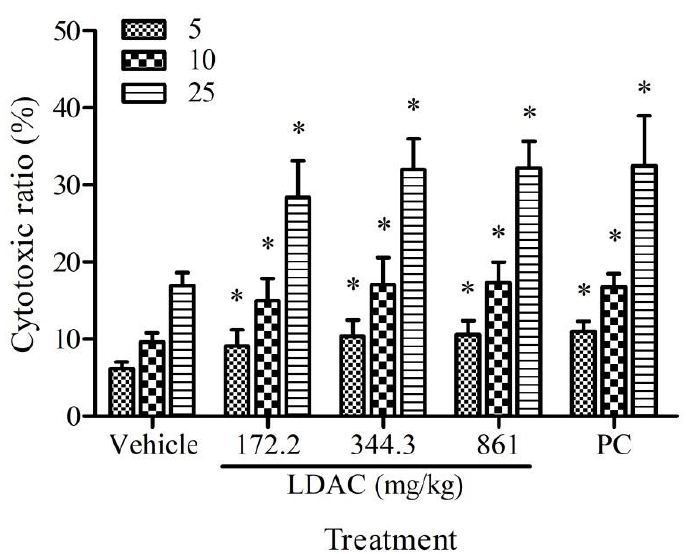
Figure 1. E ff ect of Leader Deluxe Taiwanofungus camphoratus capsule (LDAC) on cytotoxic activity of nature killer cells (NK). The mice were administered with LDAC (172.2, 344.4, 861 mg / kg) and positive control (PC, 633.5 mg / kg) for 6 weeks. The cytotoxic activity of natural killer cells was measured by incubation of e ff ector cells (NK cells) with target cells (YAC-1 cells) at the ratio (E / T ratio) 5:1, 10:2, and 25:1. The percentage of dead YAC-1 cells represented the cytotoxic activity of NK cells. All data are presented as mean ± SD. * p < 0.05 compared to vehicle